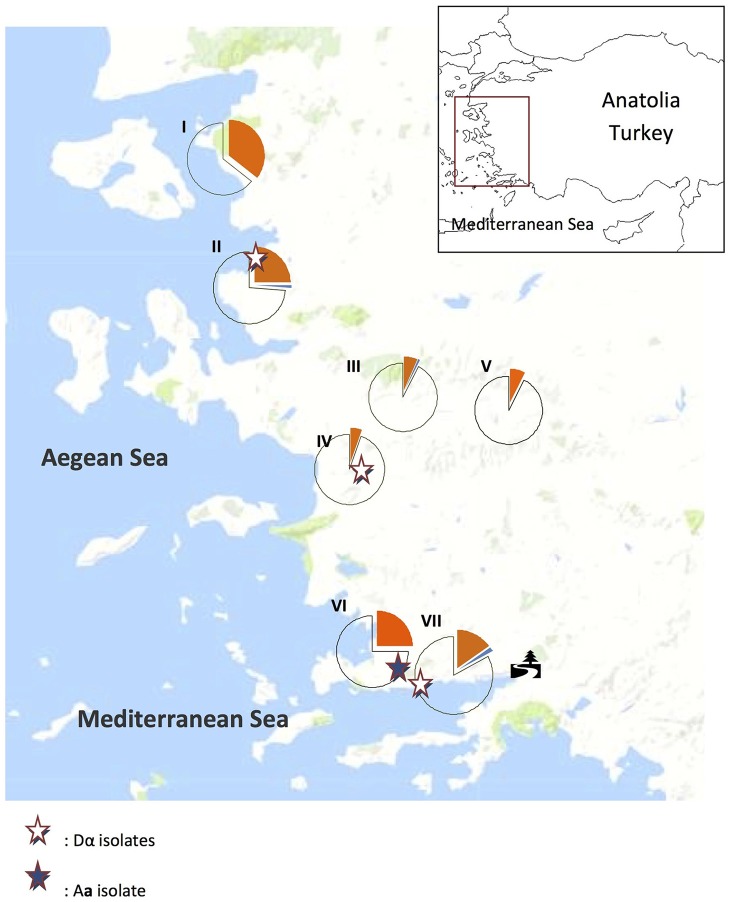
Distribution of trees with Cryptococcus neoformans (orange) and C. deneoformans (blue) colonization and uncolonized (unshaded) trees in Aegean Anatolia, Turkey. The tree symbol designates the region where C. neoformans is recurrently isolated from Eucalyptus camaldulensis.